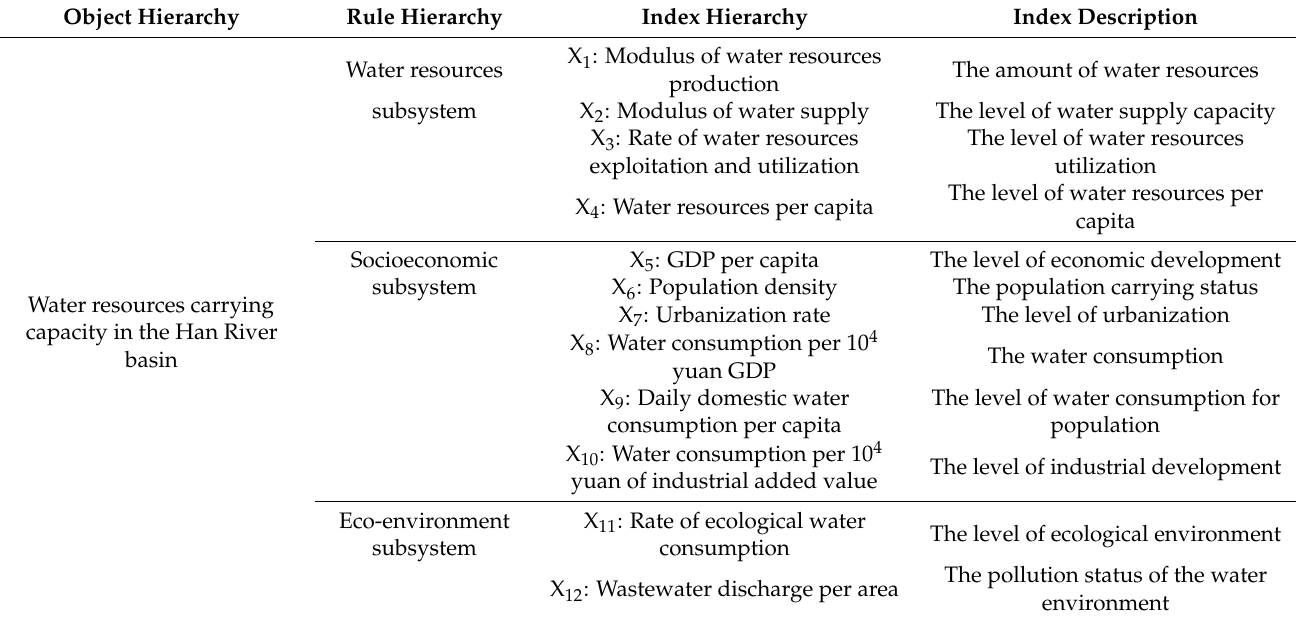
Table 2. Evaluation index system of water resources carrying capacity in the Han River